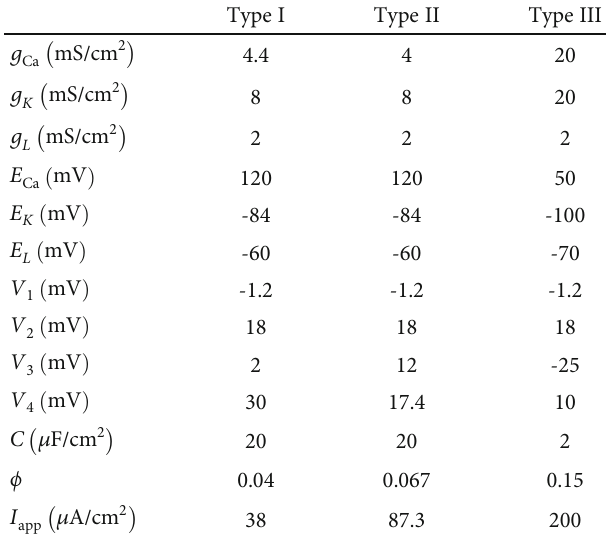
Table 1: Parameter values for 3 types of excitability Morris-Lecar